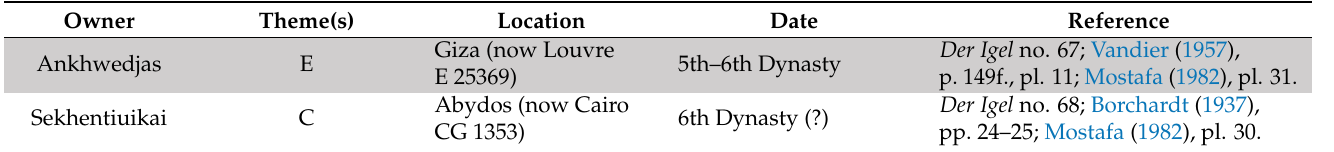
Table 2. Hedgehog-head boats represented upon Old Kingdom offering tables.